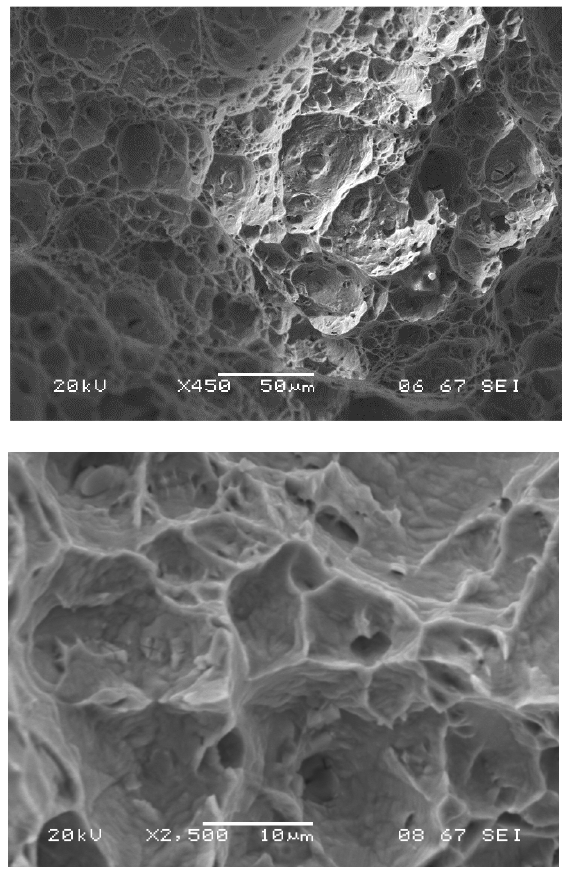
Figure 15. SEM pictures for “R1” under ELCF, show rough dimpled surfaces created by microvoids growth and coalescence with no signs of striations due to ELCF. The upper and lower images show a magnification of X450 and X2500, respectively.